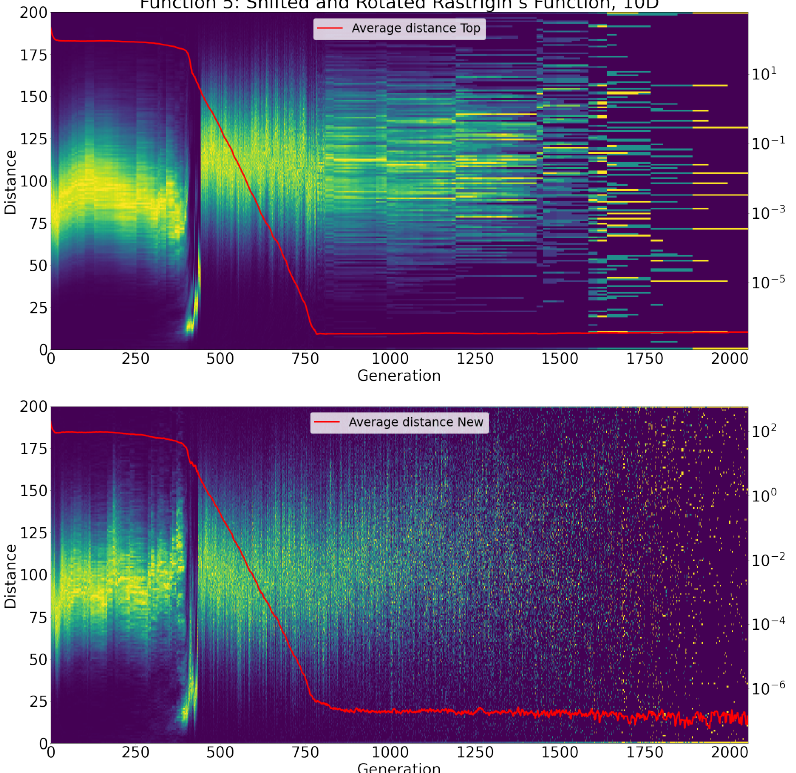
Figure 2. Heatmap of pairwise distance histograms on every generation, F5, CEC 2017, 10 D .